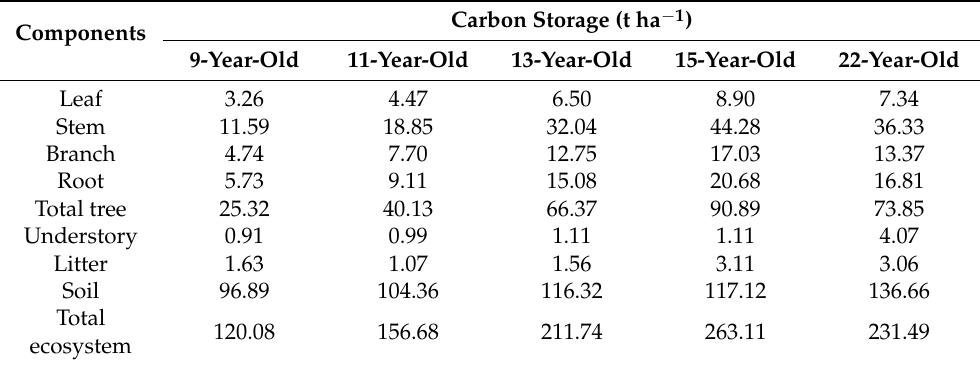
Table 5. Carbon storage of different ecosystem components in the 9-, 11-, 13-, 15-, and 22-year-old T . Zhongshanshan